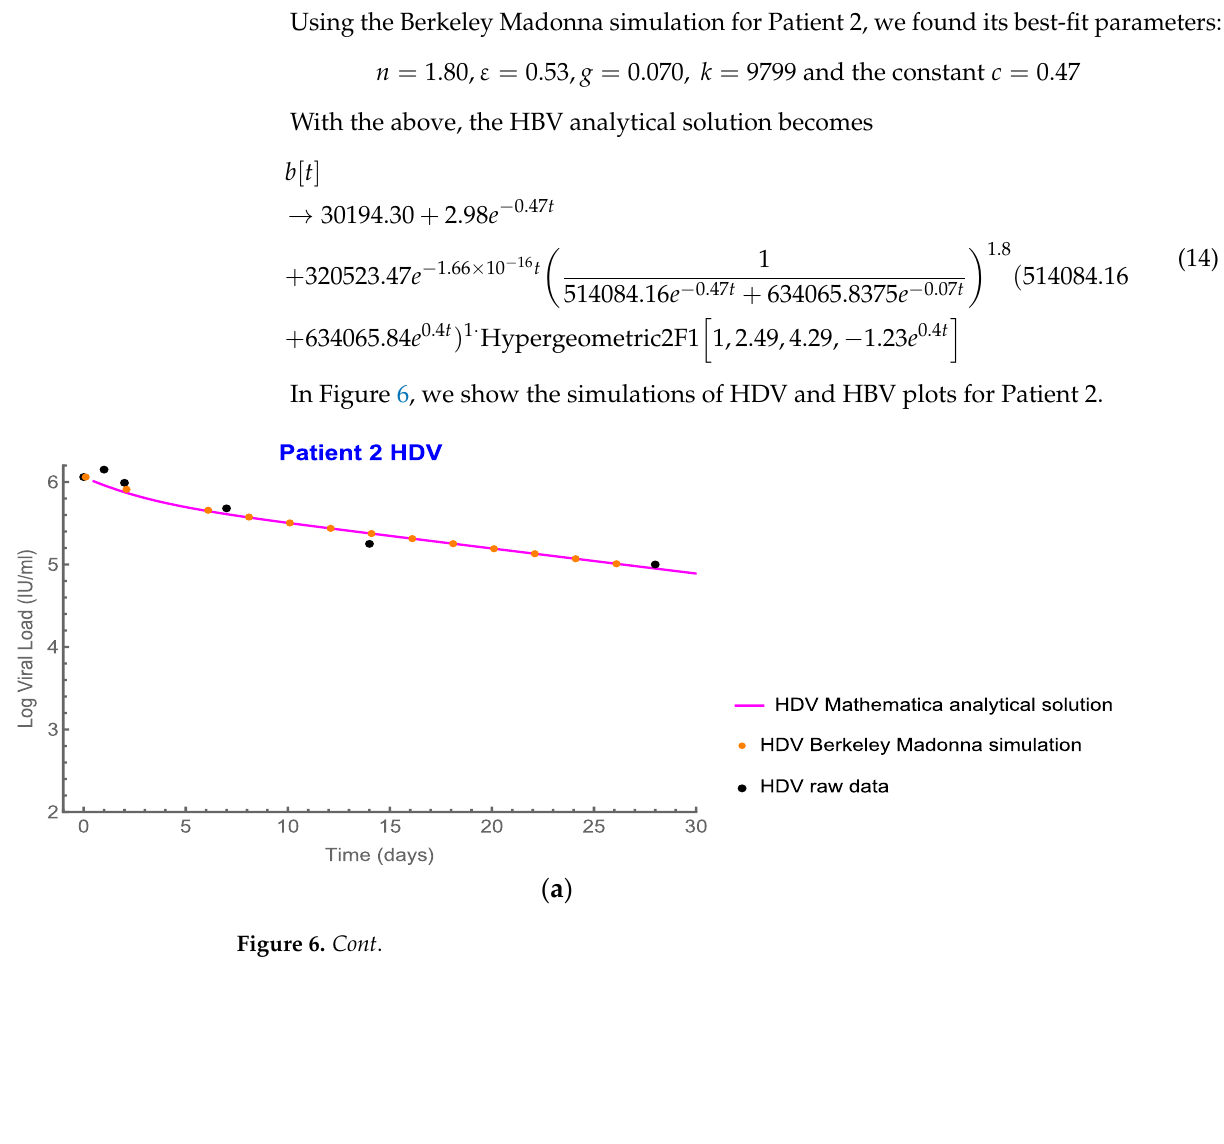
Figure 5. ( a ) shows the HBV Mathematica analytical solution (i.e., Equation (13) herein), HBV Berkeley Madonna fit for Patient 10, which was a result of fitting the modified model Equations (1) and (5) with measured data using Berkeley Madonna. ( b ) follows a similar approach as conducted in 5a but for HDV using D.